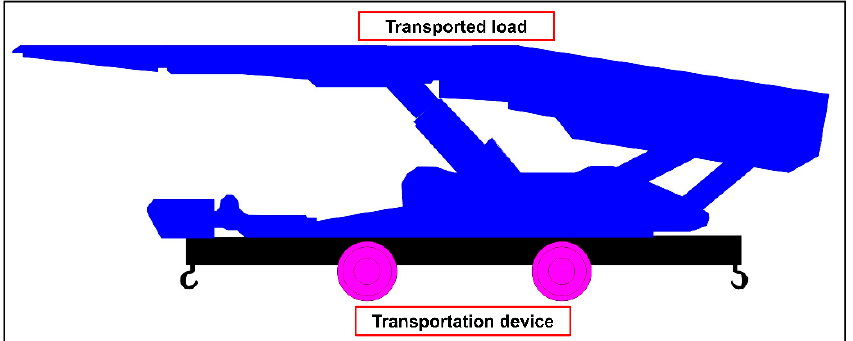
Figure 1. Example of transportation of big-size load on a transportation platform.